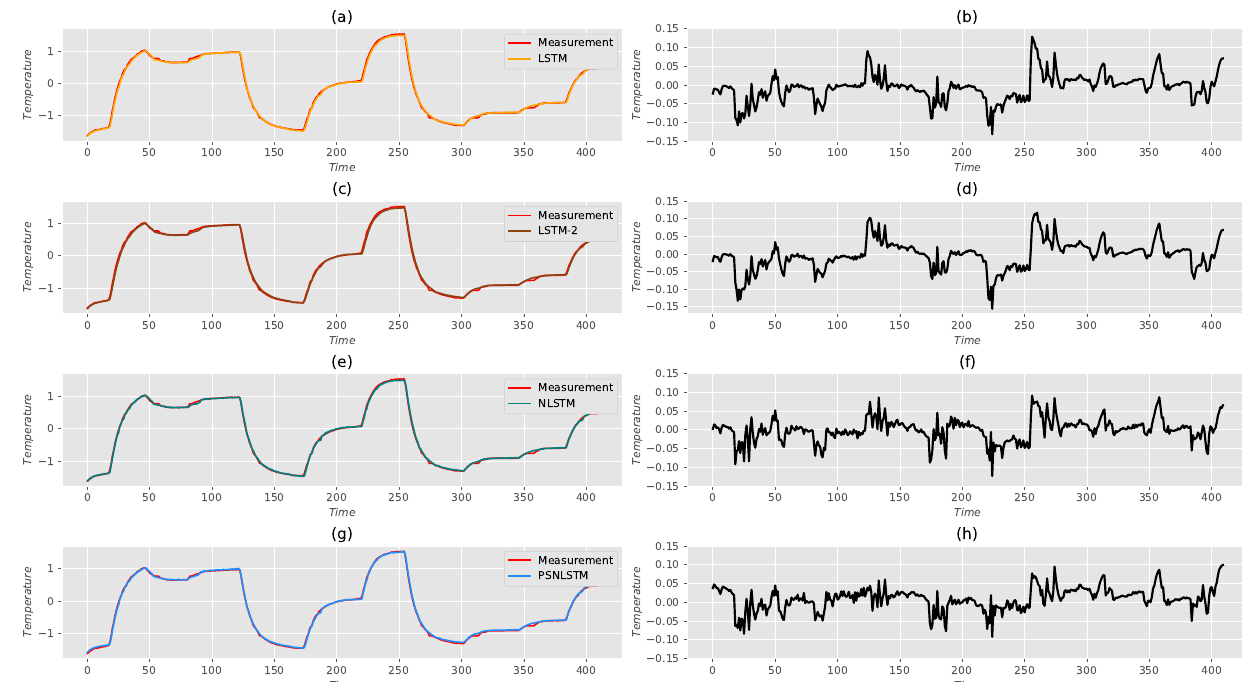
Figure 7. Temperature prediction of ϑ ST for each model. ( a , c , e , g ) the temperature fitting curves of ϑ ST for each model; ( b , d , f , h ) the temperature prediction error curves of the ϑ ST for each model, which are obtained by subtracting the measured values from the predicted values. In addition, the error curves correspond to the left fitting curves,